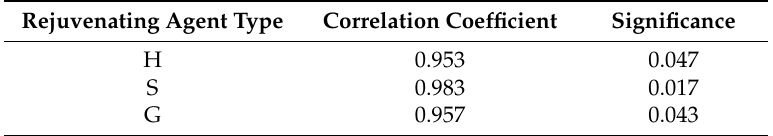
Table 10. Correlation of area ratio of SBS particles and tenacity with proportion of rejuvenating agents.